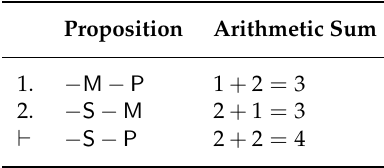
Table 5. An interpretation of eee